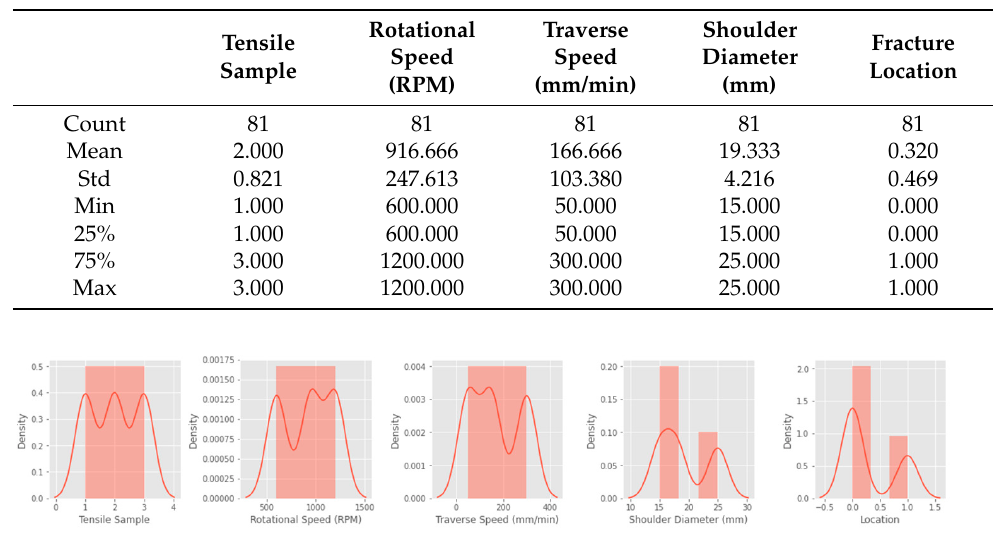
Table 1. Statistical Analysis.